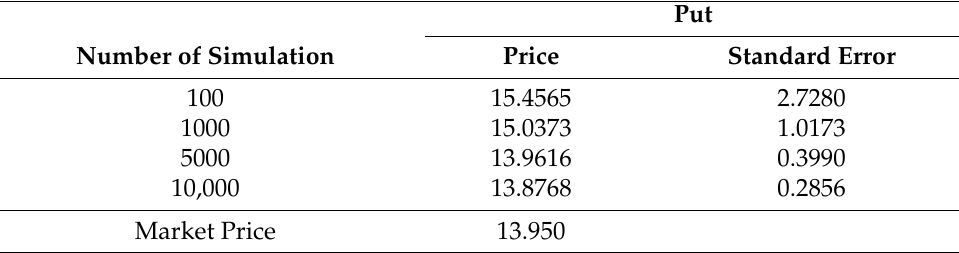
Table 7. MCS prices and standard errors for the OEX put with time to maturity of T = 31 days and strike price K = 910 using parameters calibrated on 6 April 2016.